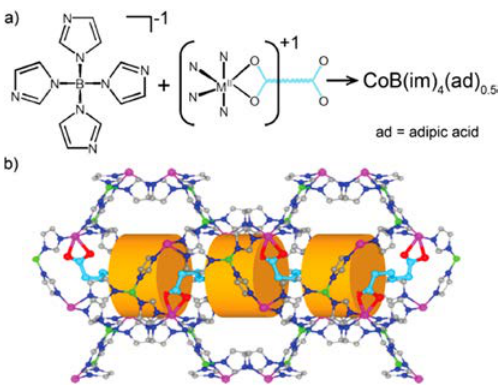
Figure 2. ( a ) Strategy for the synthesis of BIFs showing pore space partition; and ( b ) GIS-type framework of the BIF-41 material. Reprinted with permission from. Reference